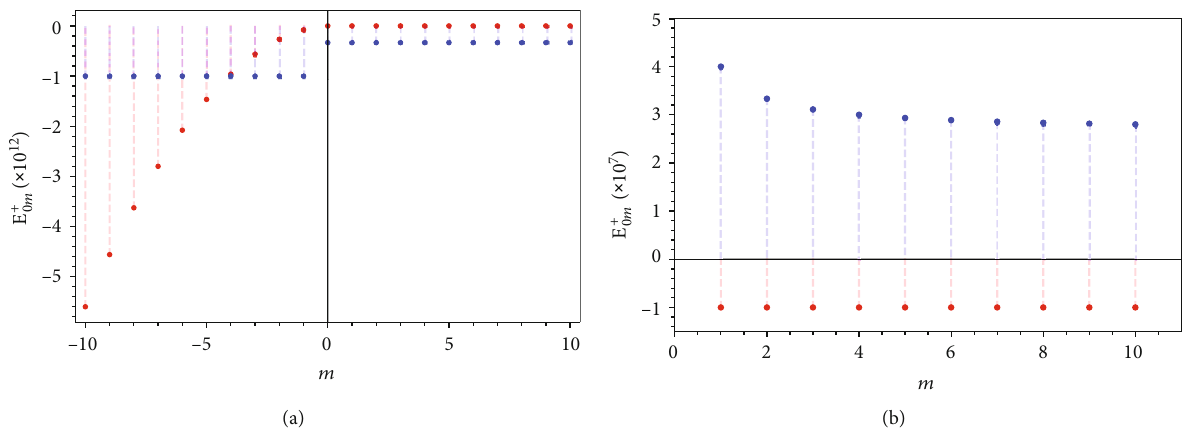
Figure 3: Illustration of the energy eigenvalues in the spin symmetry limit (equation (55)) as a function of the parameter m for (a) s = 1 and (b) s = − 1 . We use units such as M = 1 , n = 1 , b = 1 , and ε = 10 − 7 .